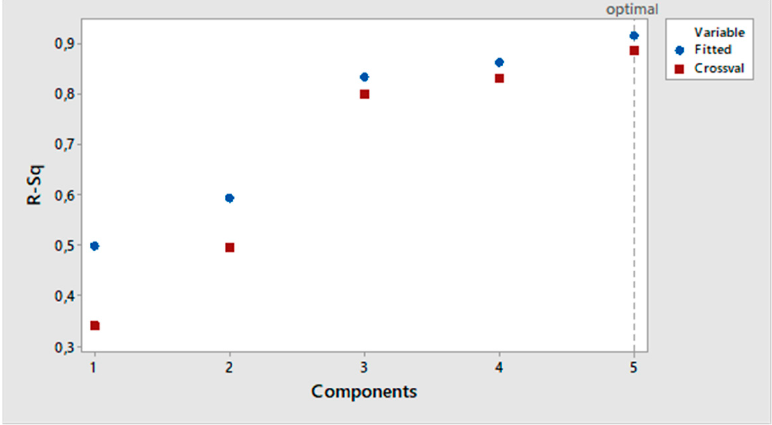
Figure 8. PLS model selection plot—E u 50 .